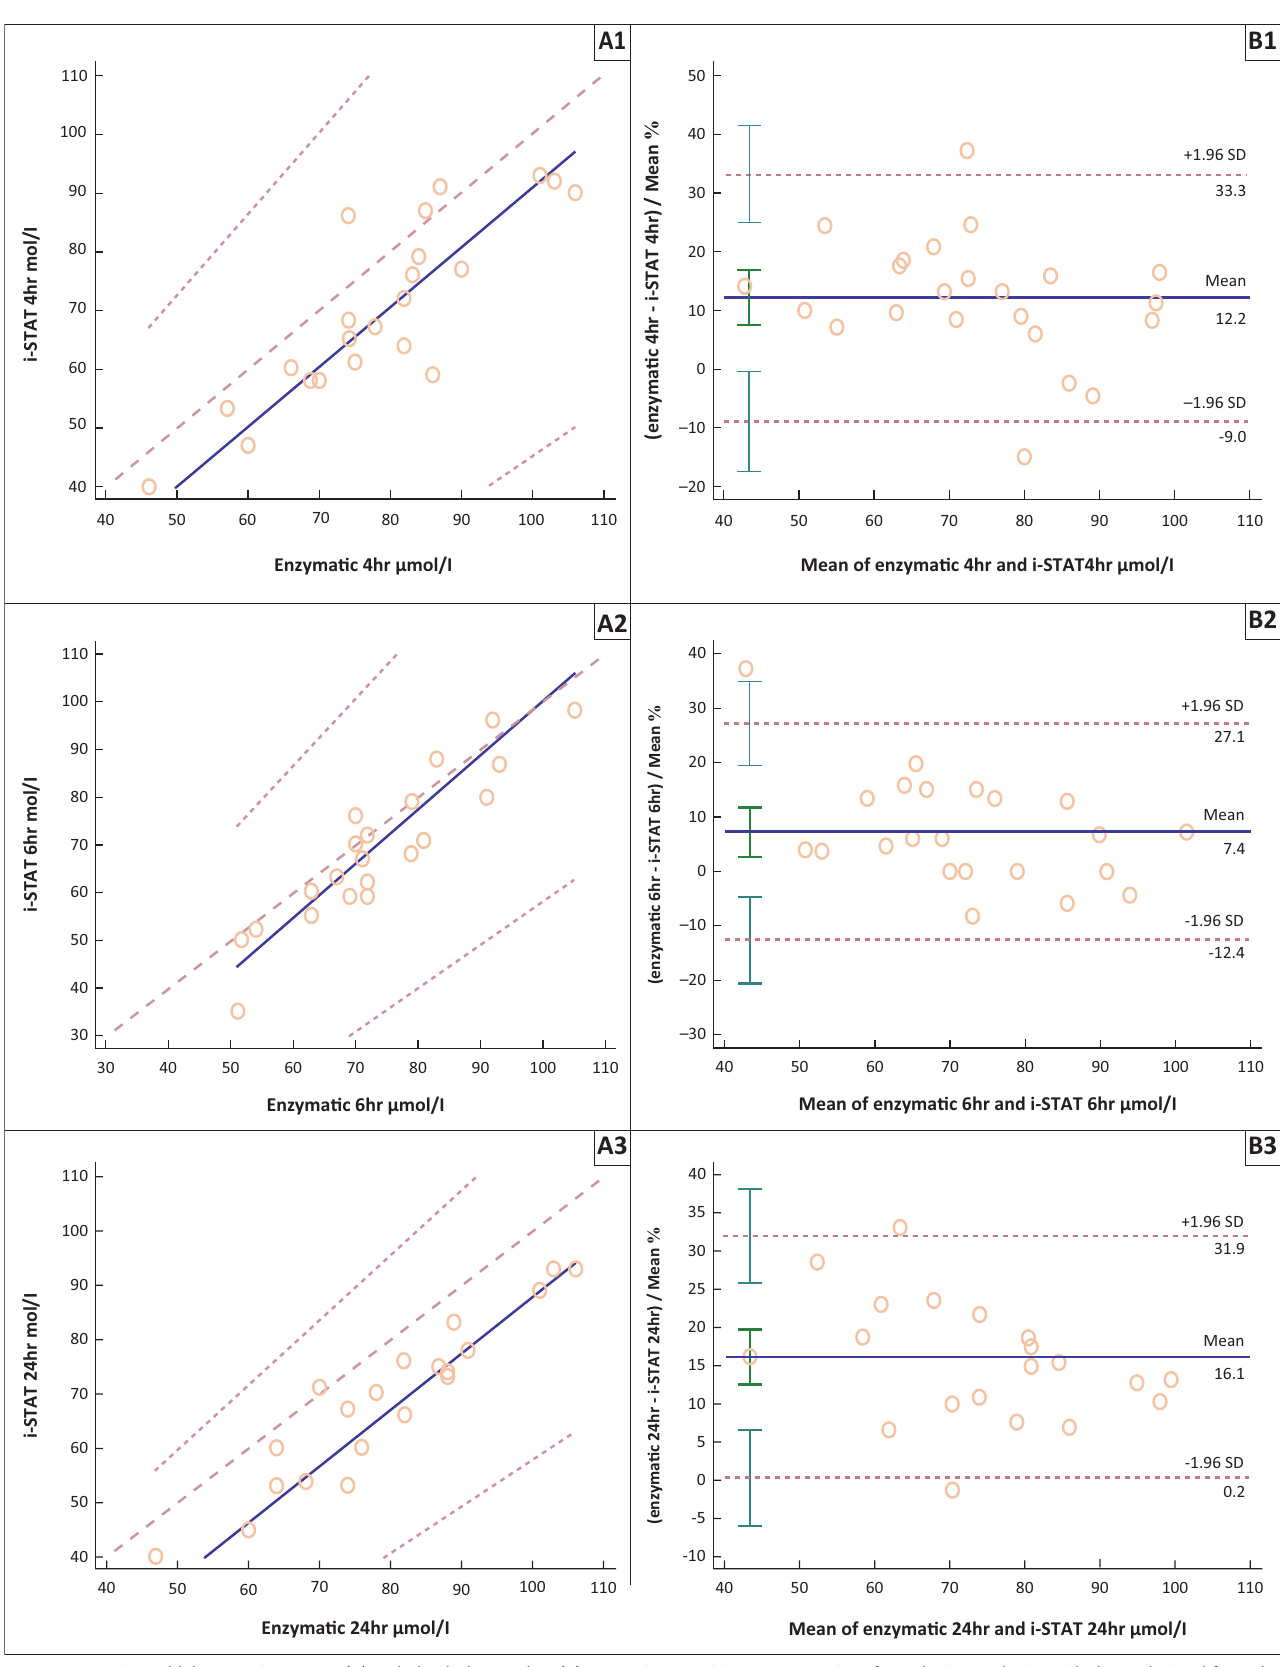
Figure 4 continues on the next page